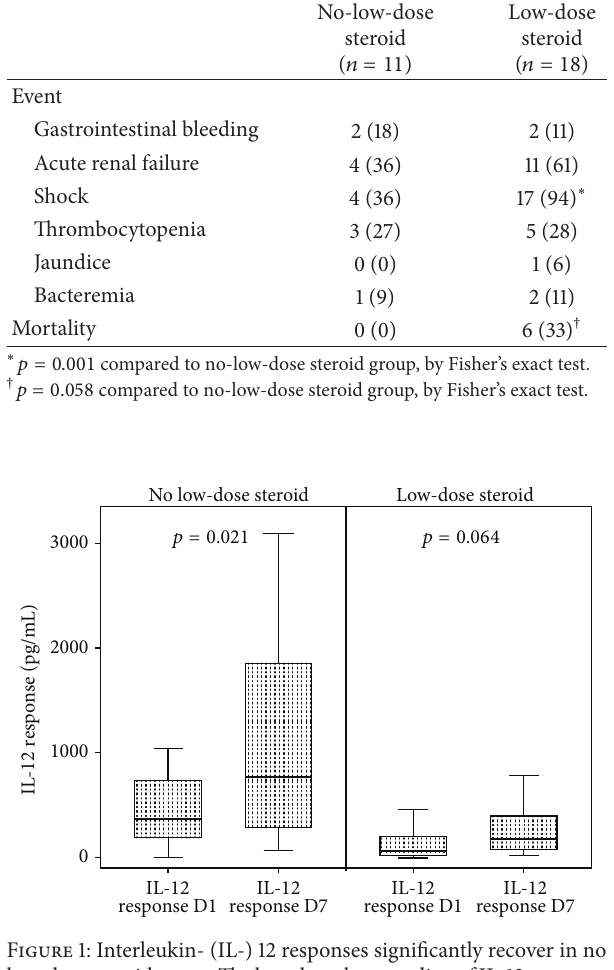
Table 2: Adverse event and outcome (number, percentage). No-low-dose